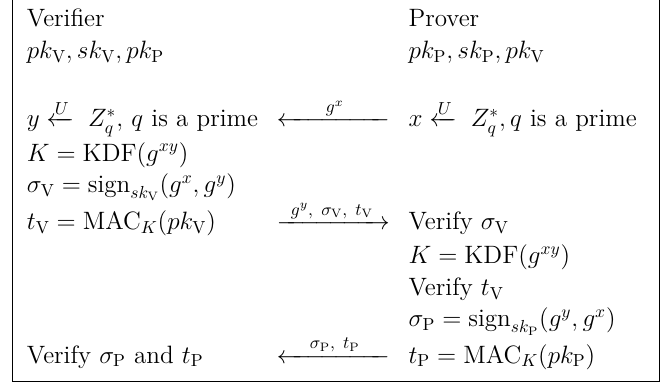
Figure 3: Authenticated key exchange – the SIGMA protocol